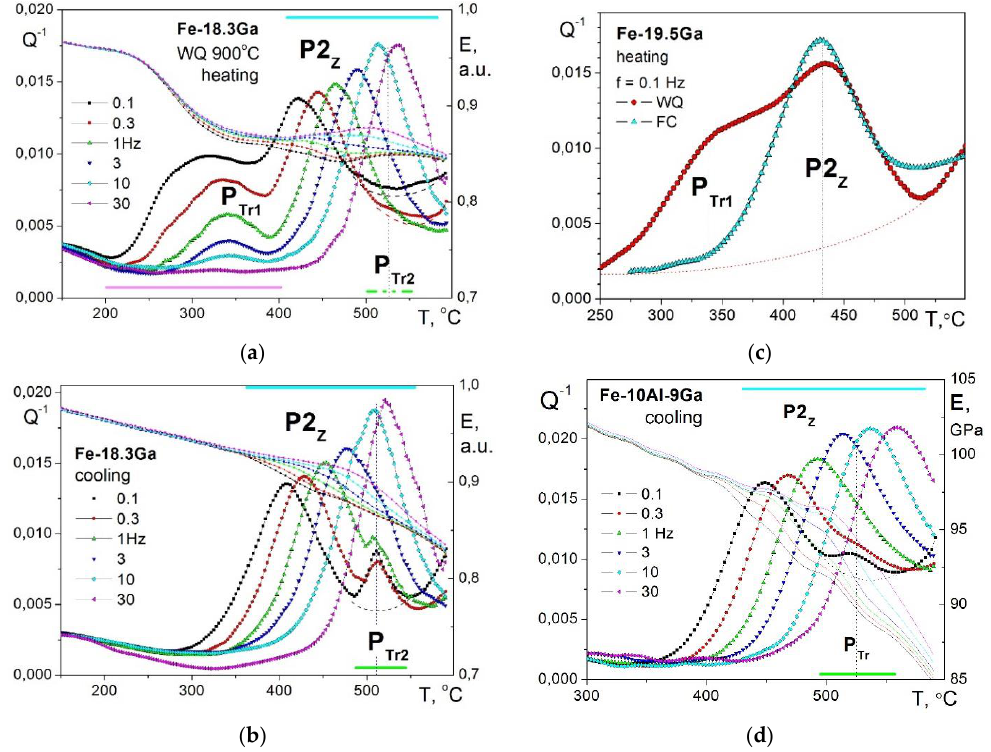
Figure 9. TDIF curves for Fe–18.3Ga after water quenching from 900 °C at heating ( a ) and cooling ( b ); Fe–19.5Ga after water quenching (WQ) and furnace cooling (FC) after annealing at 900 °C ( c ) and Fe–10Al–9Ga ( d ) at cooling.